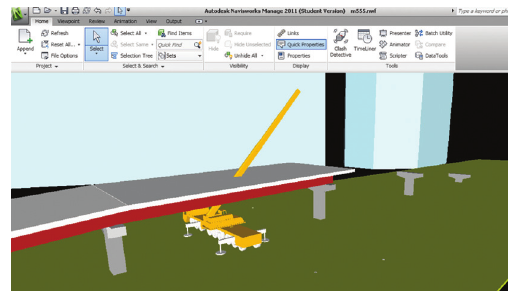
Fig. 10. Excluded location due to clashes